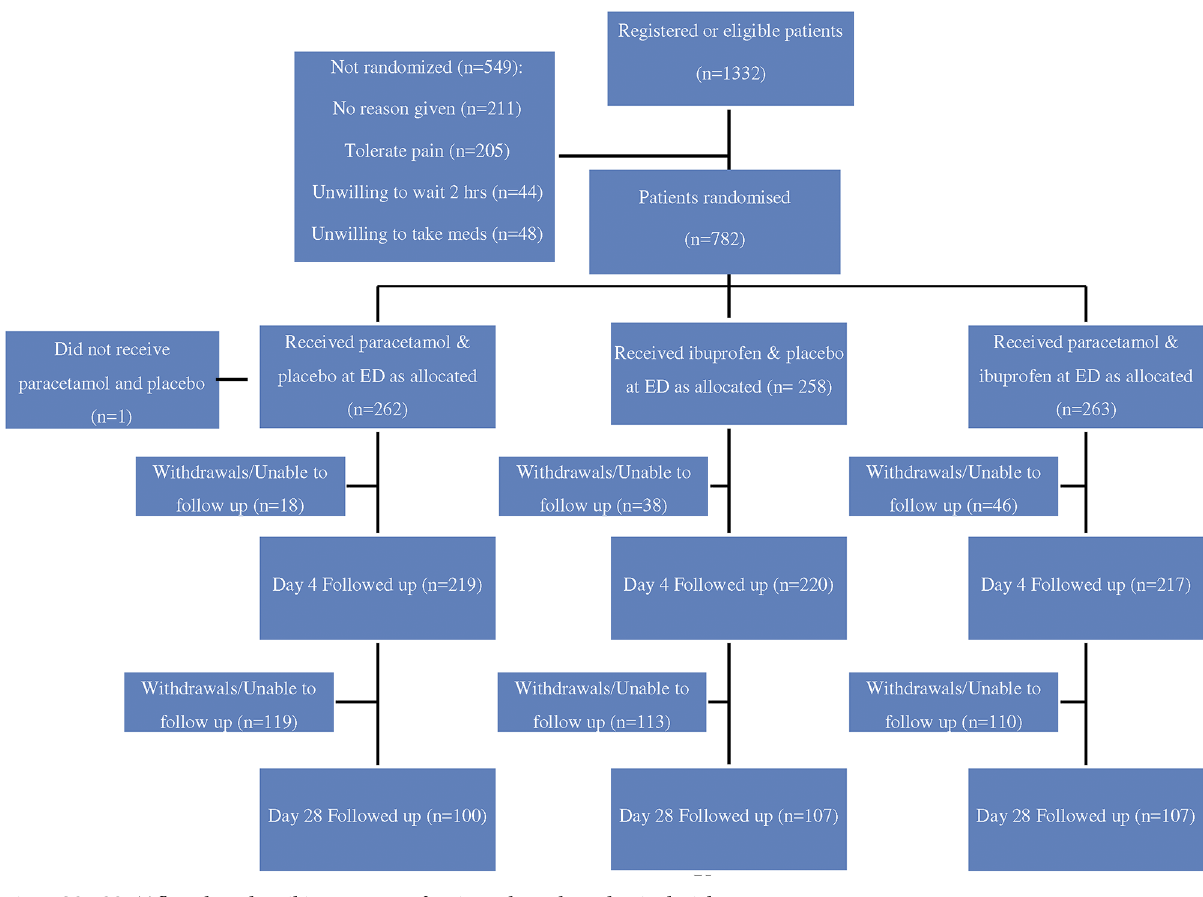
Fig 1. CONSORT flow chart describing progress of patients through randomised